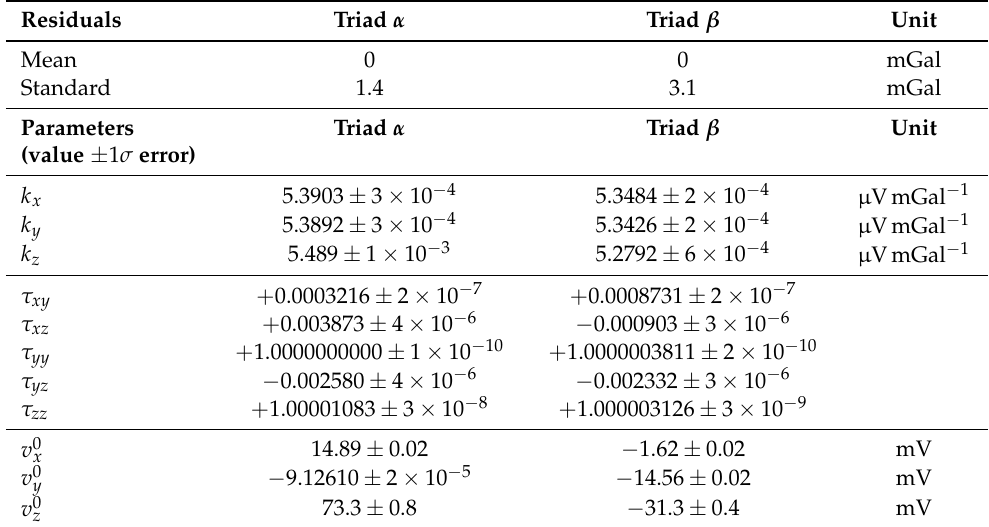
Table 2. Mean and standard deviation of the residuals (Equation (35)) obtained with our adjustment method and corresponding values of the internal parameters (scale factors, misalignment components, biases) for the triads α and β